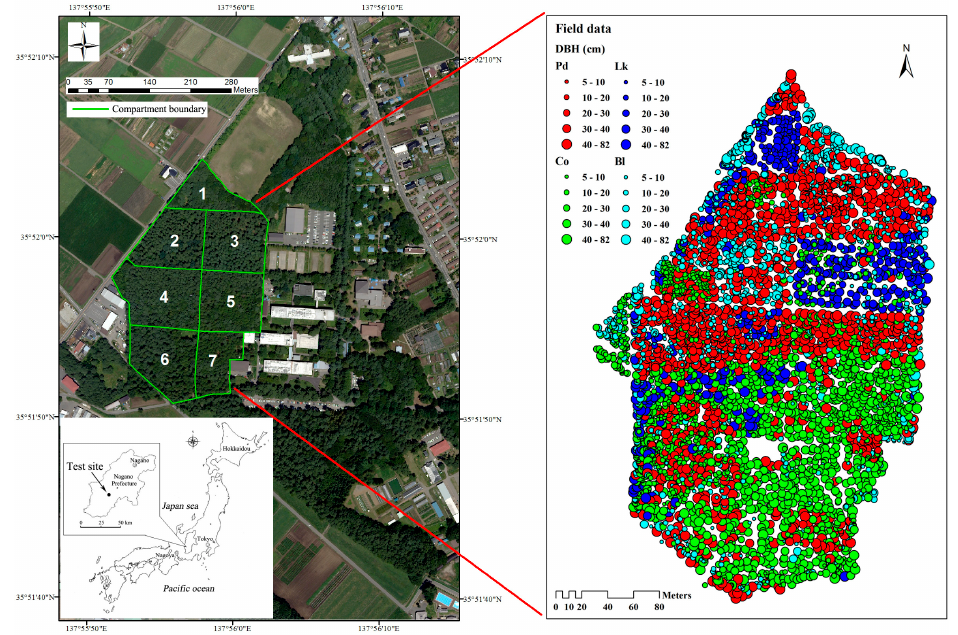
Figure 1. A map of the study area showing field data collected from April 2005 to June 2007. DBH, diameter at breast height; Pd, Pinus densiflora ; Co, Chamaecyparis obtusa ; Lk, Larix kaempferi ; Bl, broadleaved trees.